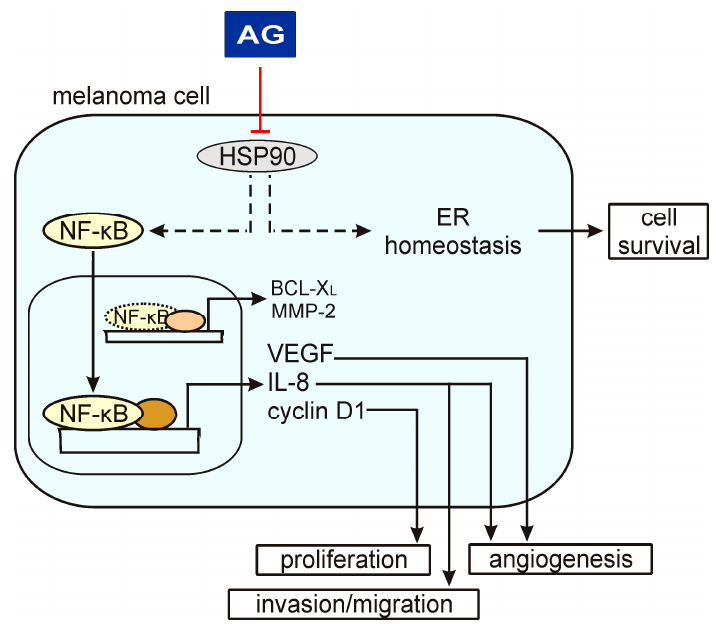
Figure 6. A schematic model of AG activity in melanoma cells based on the results shown in this study and published previously [21]. A heat shock protein 90 (HSP90) has been shown to control the p65/NF- κ B signaling pathway and endoplasmic reticulum (ER) homeostasis, among others. AG inhibits HSP90 activity that is associated with a reduction of phospho-p65 levels and expression of NF- κ B target genes, including VEGF , CXCL8, and CCND1 . In this way, AG can affect different cellular programs. In turn, AG does not change the levels of BCL-X L and MMP-2, suggesting that regulators other than NF- κ B play a dominant role in the activation of their expression.